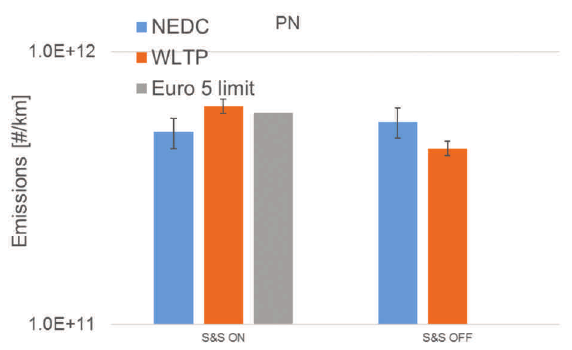
Fig. 6. PN emissions (solid particles only) from vehicle